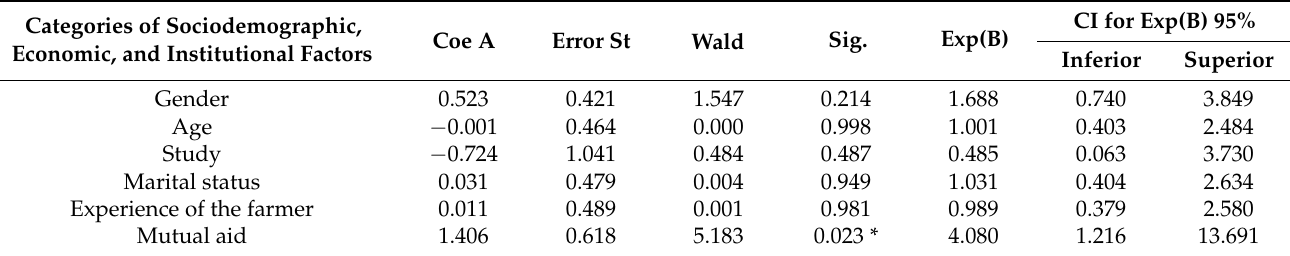
Table 8. Logit model estimation of ISFM